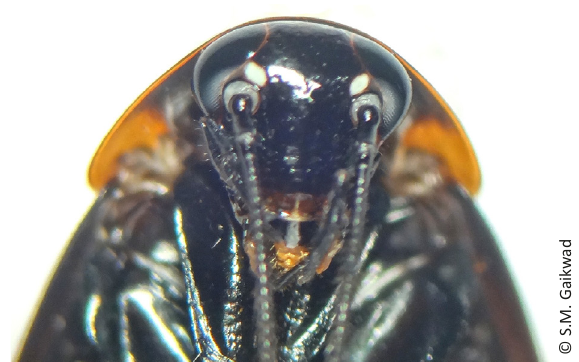
Image 3. Hemithyrsocera palliata - pronotum dorsal view